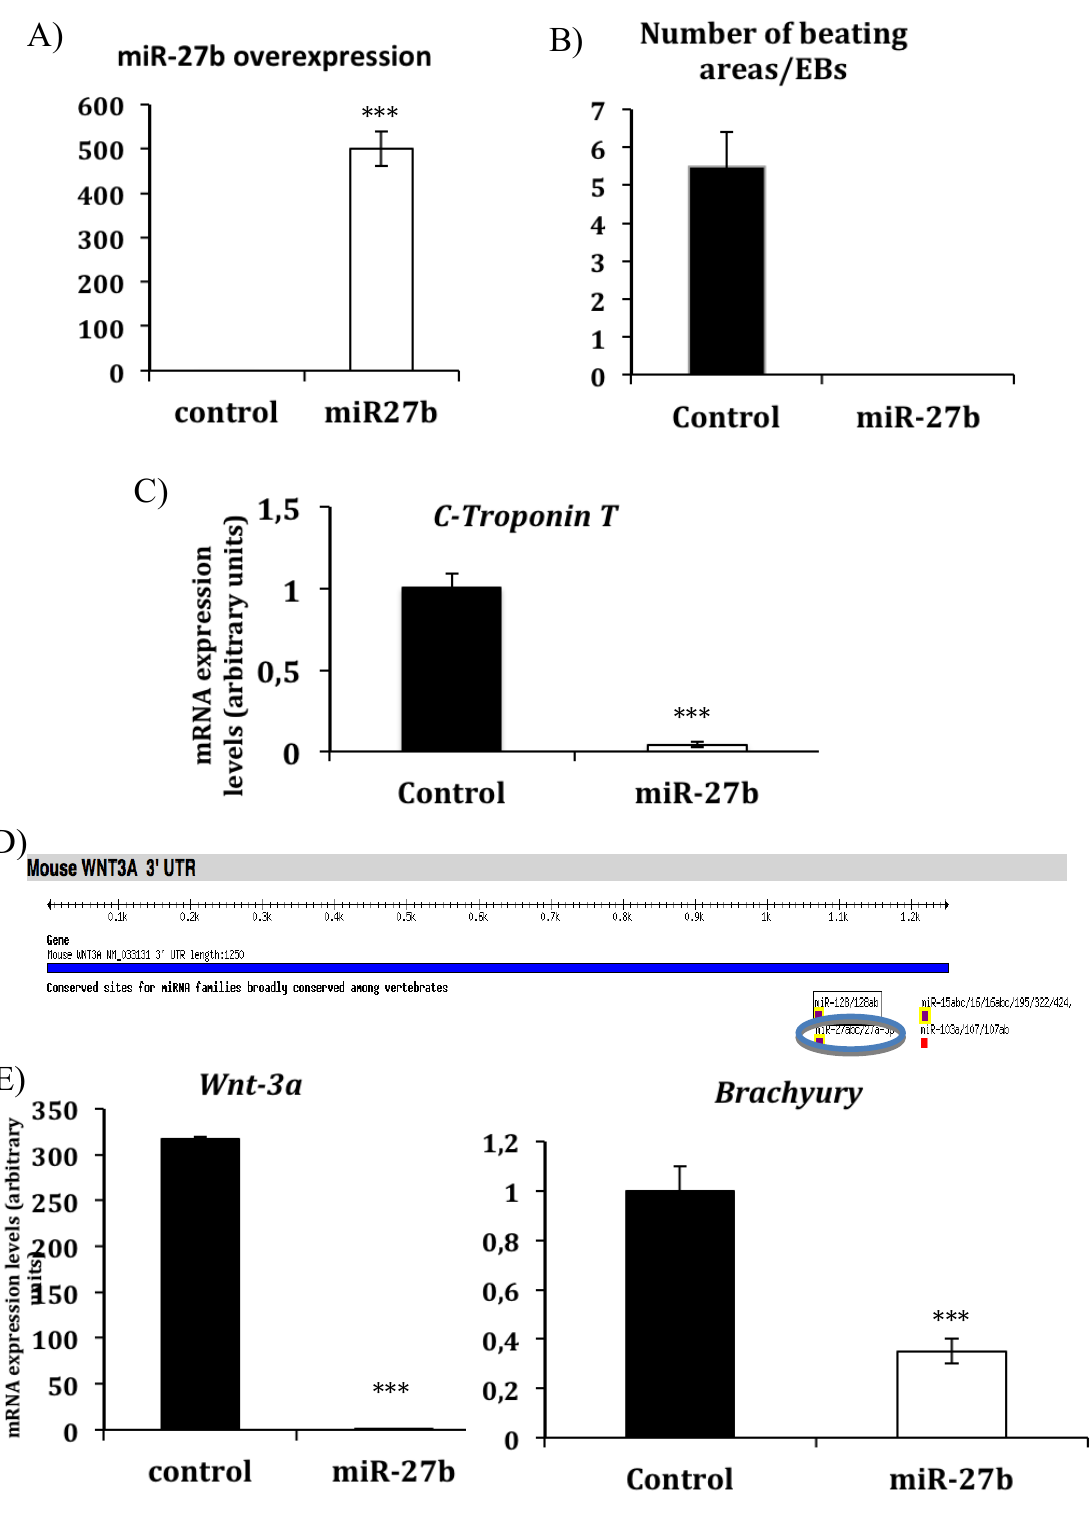
Figure 1. ( A ) Overexpression of miR-27b in embryonic bodies (EBs) derived from murine Embryonic Stem Cells (ESCs) analyzed by RT-PCR. ( B ) EBs-overexpressing miR-27b fail to form beating areas (n = 22). ( C ) c-Troponin T expression profiles on EBs overexpressing miR-27b. ( D ) Schematic representation of the putative microRNA binding sites in Wnt3a 3'-UTR region as revealed by TargetScan althgoritm (www.targetscan.org). ( E ) Wnt3a and Brachyury expression profiles on EBs overexpressing